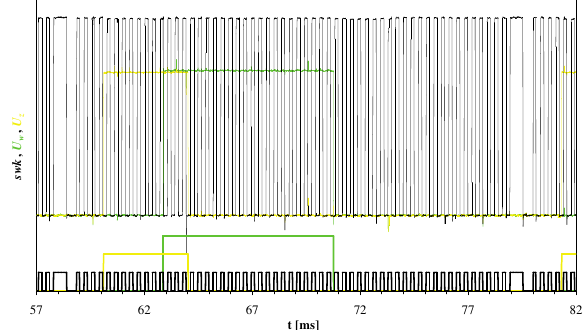
Fig. 8. Bistate signals before and after transformations into zero-one signals (on the upper part of figure registered bistate signals, on the lower part corresponding to the zero-one